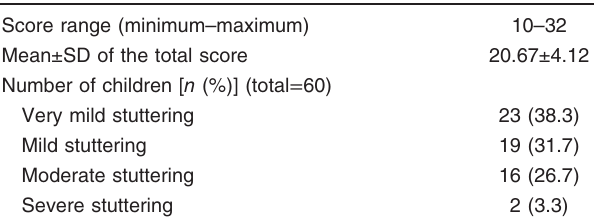
Table 6 Score range, mean score, and degree of the Stuttering Severity Instrument for Children and Adults − Arabic version, for participating children